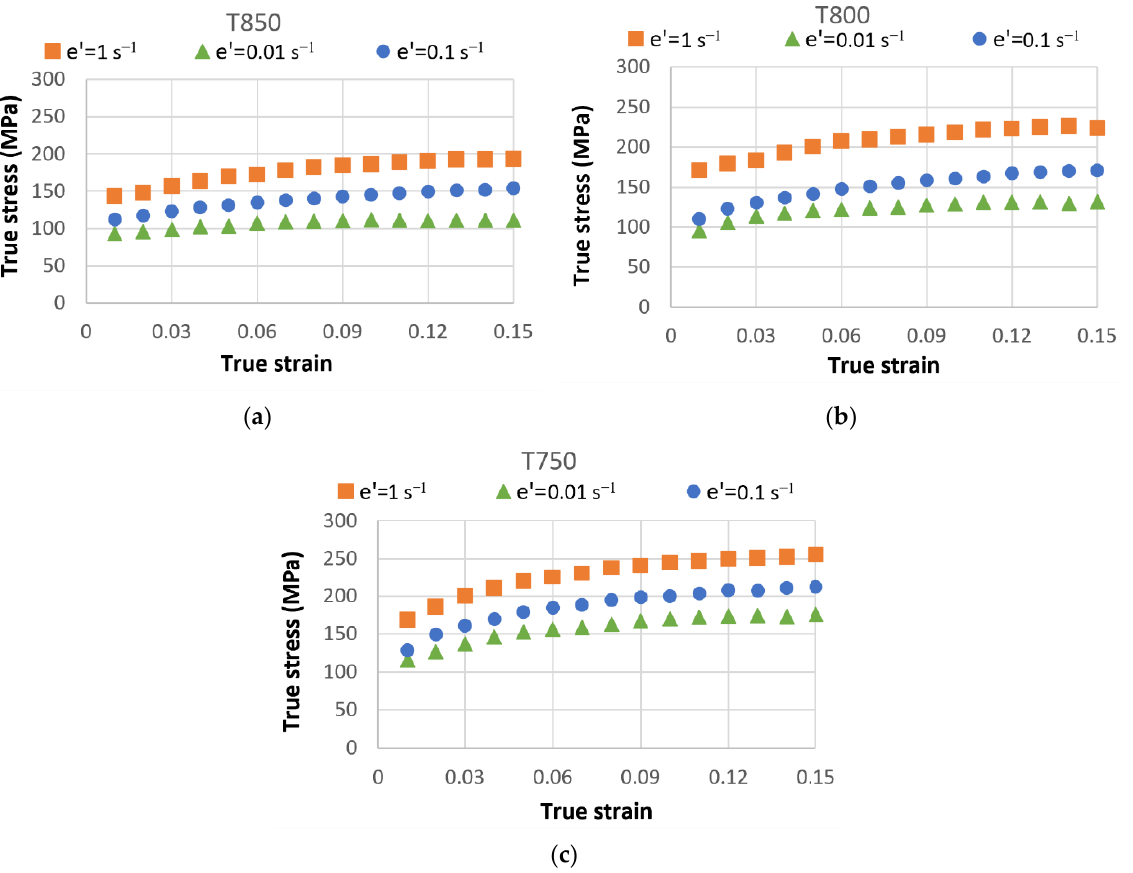
Figure 9. Stress–strain curves of the two investigated UHSS at a strain rate of 0.1 s − 1 for each test temperature investigated.